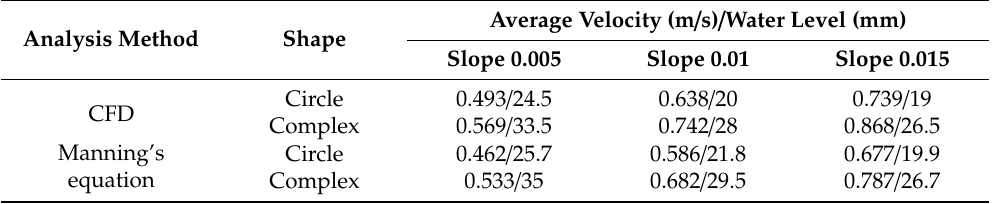
Figure 6. Velocity distribution by numerical modeling of circular pipe ( a ) and complex cross-section Table 3. Average velocity and water level of the circular pipe and the complex cross-section